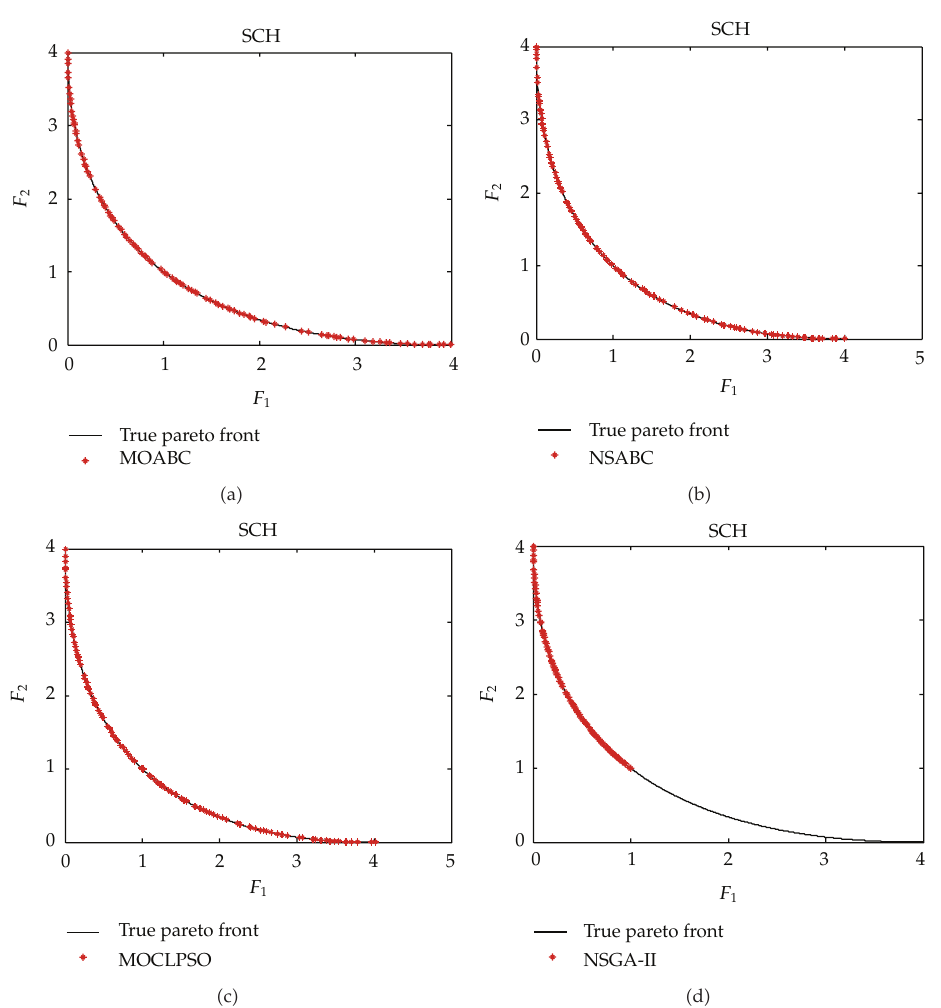
Figure 6: Pareto fronts obtained by NSABC, MOABC, MOCLPSO, and NSGA-II on SCH after 20000